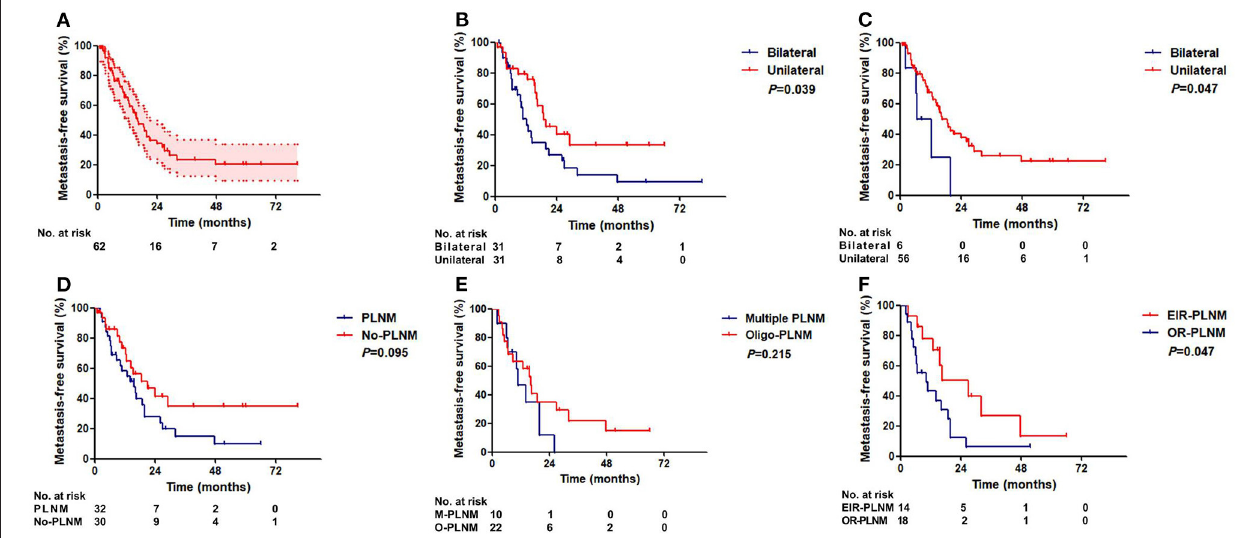
FIGURE 4 | Metastasis-free survival of ENE patients. (A) All patients. (B) Patients with unilateral and bilateral inguinal LNM. (C) Patients with unilateral and bilateral ILN-ENE. (D) Patients with and without PLNM. (E) Patients with multiple PLNM and oligo-PLNM. (F) Patients with external iliac region-PLNM and other region-PLNM (EIR-PLNM, external iliac region-PLNM; OR-PLNM, other region